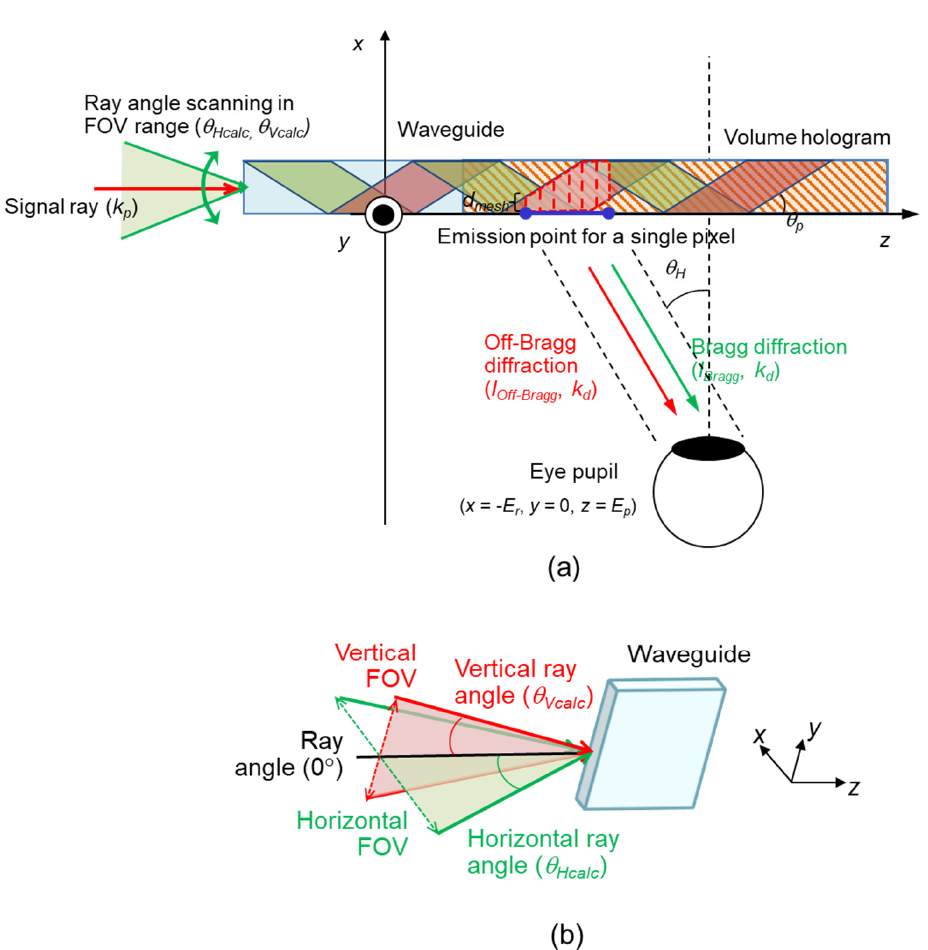
Figure 2. ( a ) Schematic of analytical model of the waveguide with off-Bragg diffraction; ( b ) Geometric definition of ray angles of readout light ( θ Hcalc and θ Vcalc ).